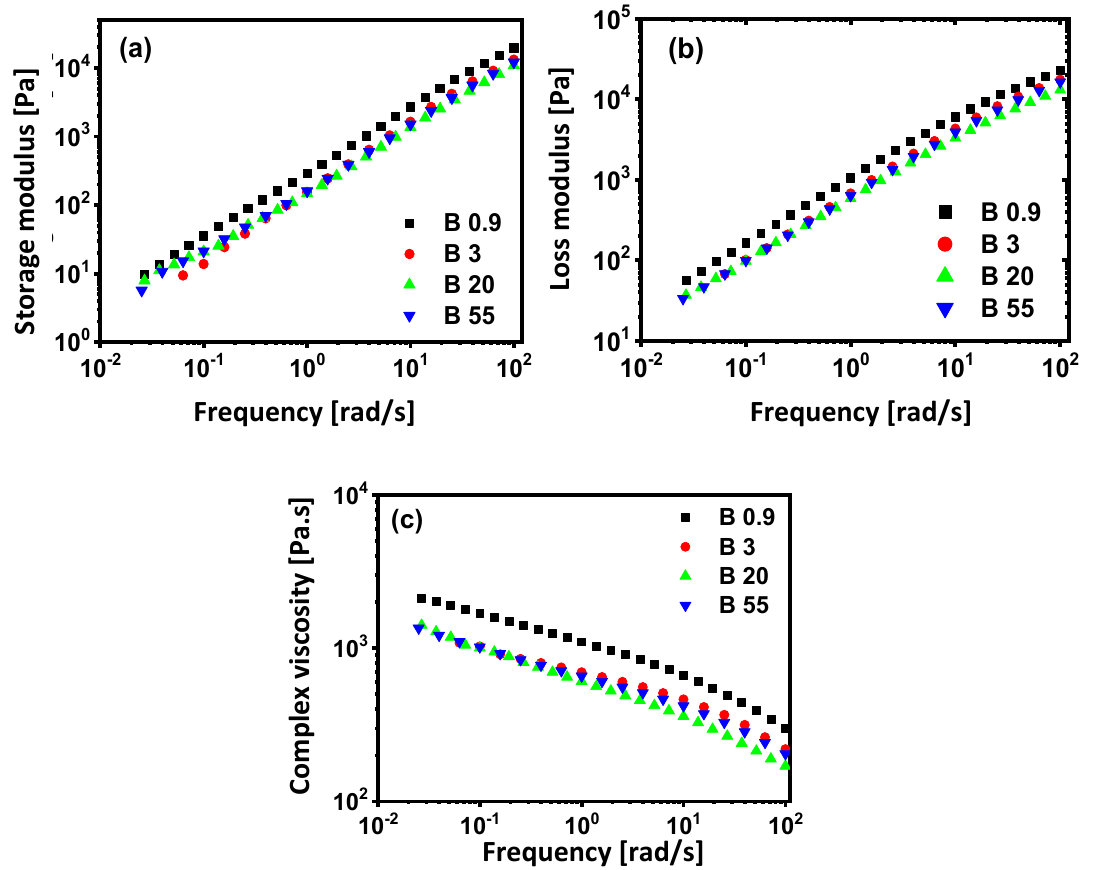
Figure 6. Evolution of ( a ) storage modulus, ( b ) loss modulus, and ( c ) complex viscosity for PS80/PP20 blends with different viscosity ratio ( K ) values as a function of frequency during oscillatory testing at 200 °C.